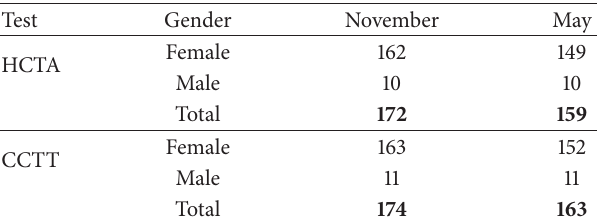
Table 1: Number of participants in each administration period, by